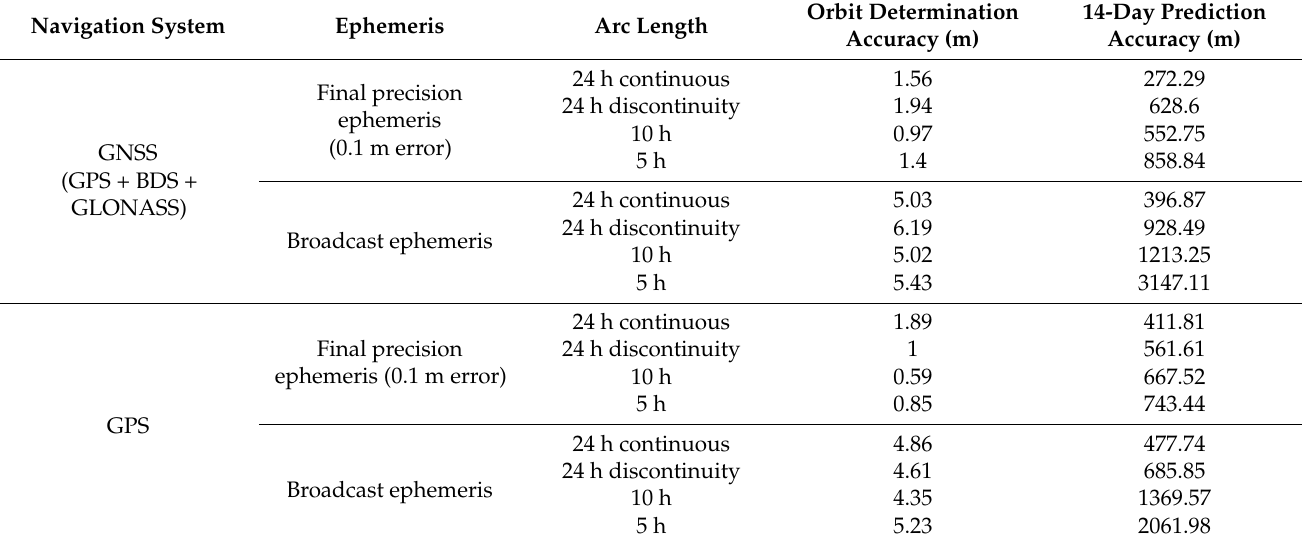
Table 6. Orbit determination and prediction of different